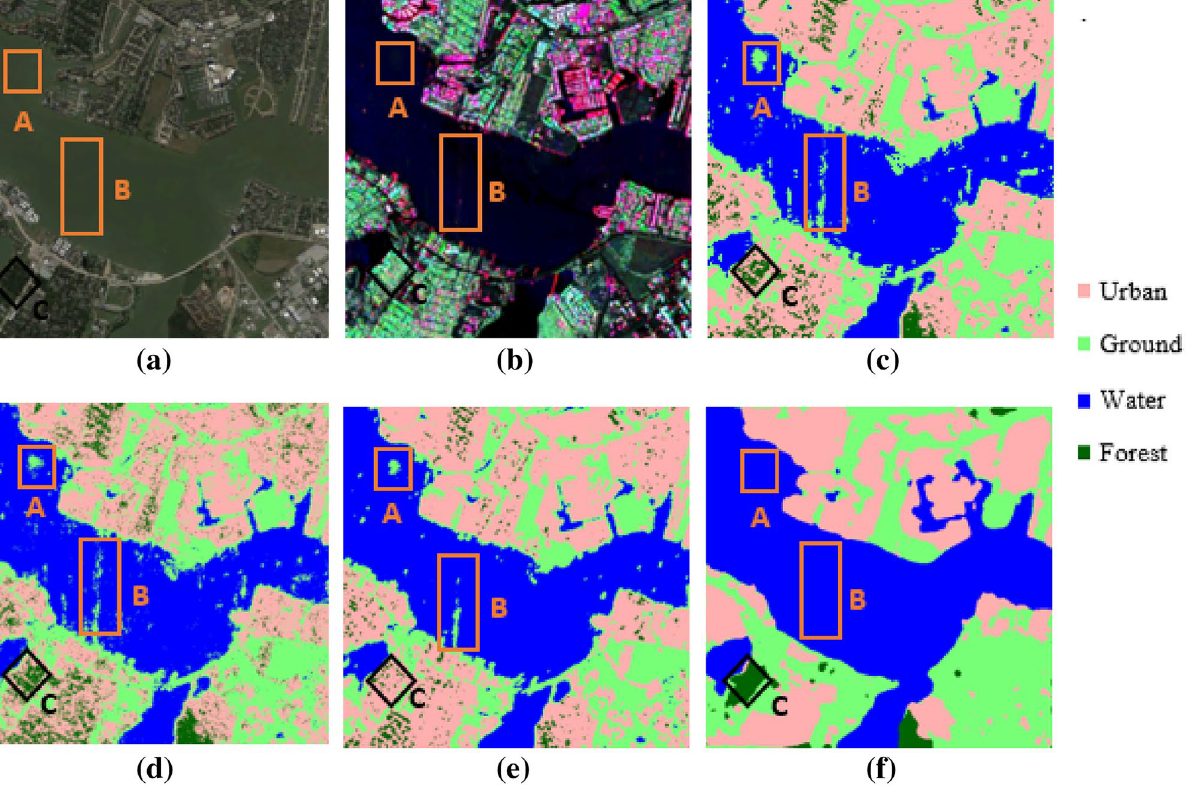
Figure 1. Represents the ground truth of Houston City, Texas (patch 1) and respective segmentation results of various classifiers ( a ) Google Earth image of test patch 1 ( b ) False color composite image for G4U decomposition on UAVSAR data of a part of Houston City, Texas (USA) and the corresponding image segmentation results for ( c ) RF classifier, ( d ) KNN classifier, ( e ) SVM classifier, and ( f ) Deeplab V3